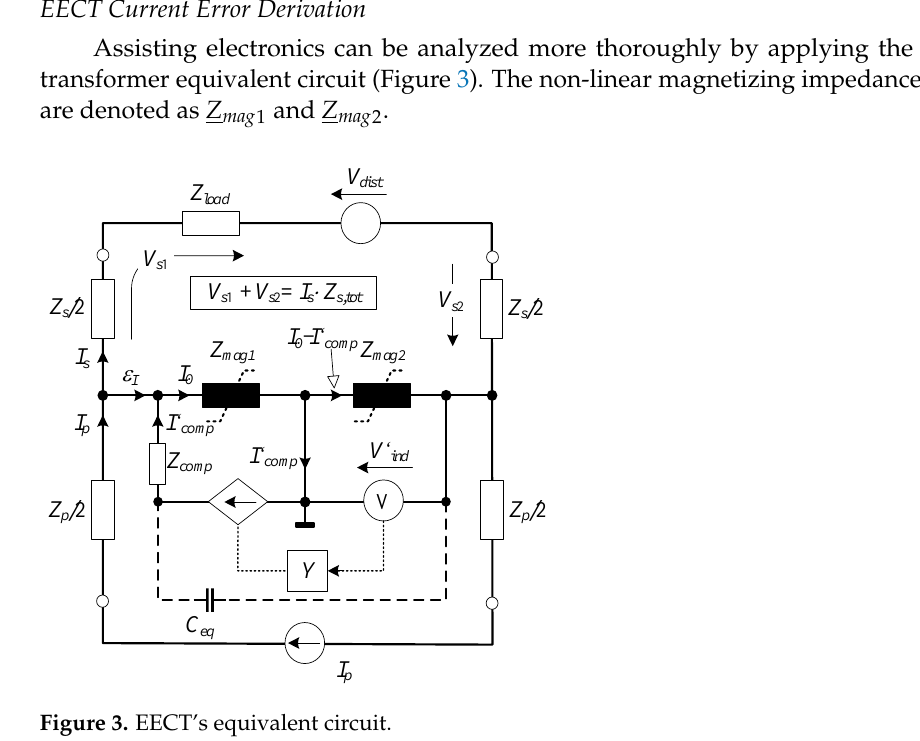
Figure 3. EECT’s equivalent circuit .